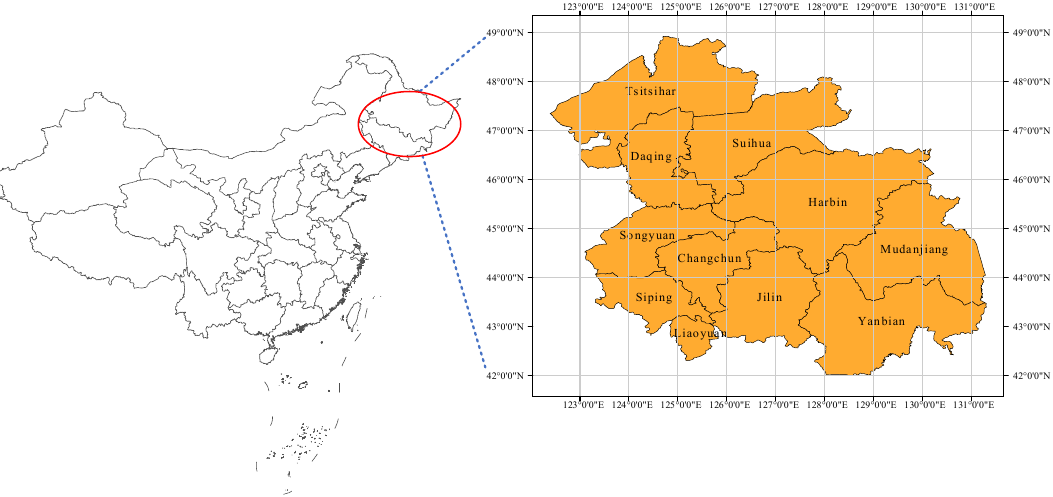
Figure 2. Location and range of the Harbin-Changchun urban agglomeration (HCUA).